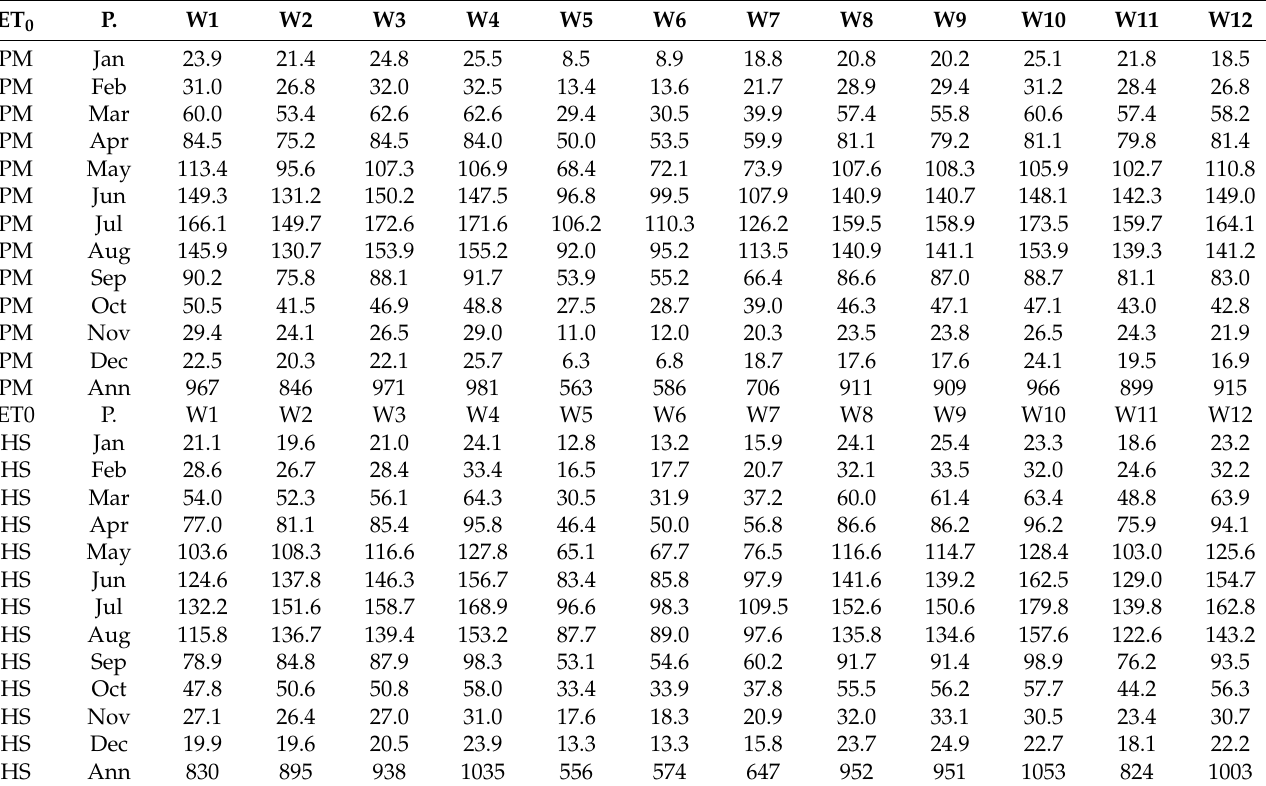
Table 4. Average annual and monthly ET0 over the period 2010–2020 calculated using the Penman–Monteith (PM) and the Hargreaves (HS) method; W5, W6, and W7 are calculated with the complete Penman–Monteith (cPM). ET 0